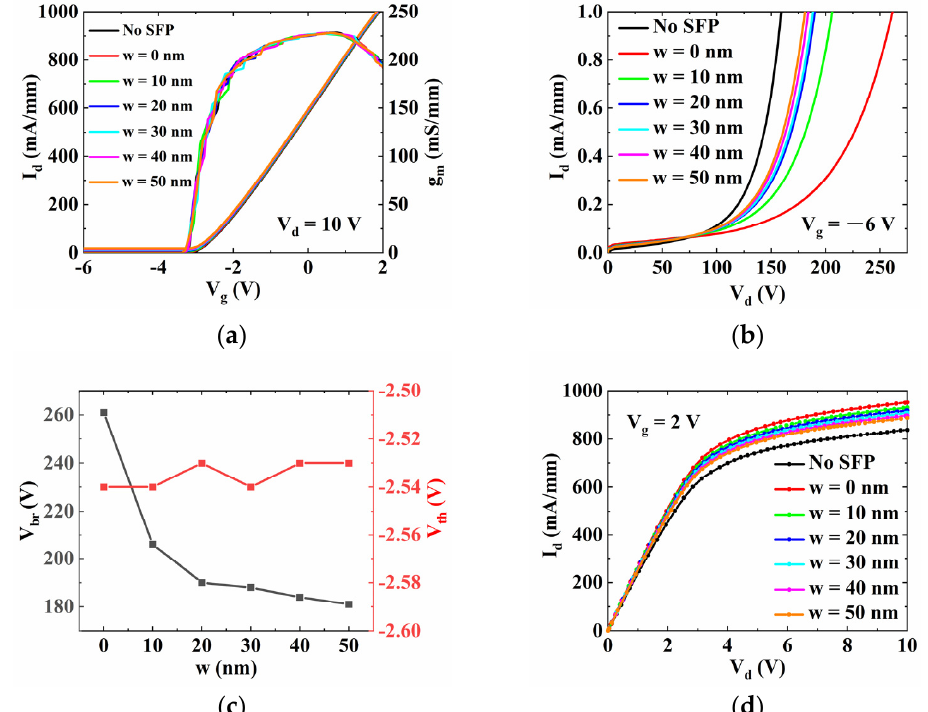
Figure 3. ( a ) Drain current and transconductance versus gate voltage; ( b ) off-state drain current versus drain voltage; ( c ) breakdown voltage and threshold voltage versus crack width; ( d ) pulsed I-V characteristics for AlGaN/GaN HEMTs without SFP and with SFP of different crack widths.